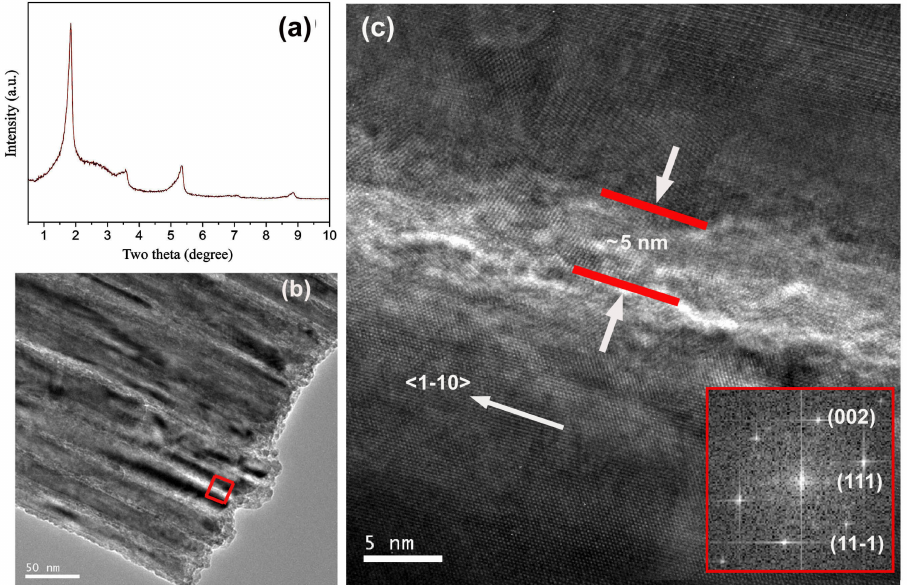
Figure 4. Figure 4. ( a ) Small angle X-ray diffraction (SAXRD) for the product after 48 h of reaction; ( b ) TEM image of CuNW bundles observed in the product after 48 h of reaction; ( c ) An enlarged version of the framed region in Figure 4b. Inset of Figure 4c is the corresponding reduced FFT